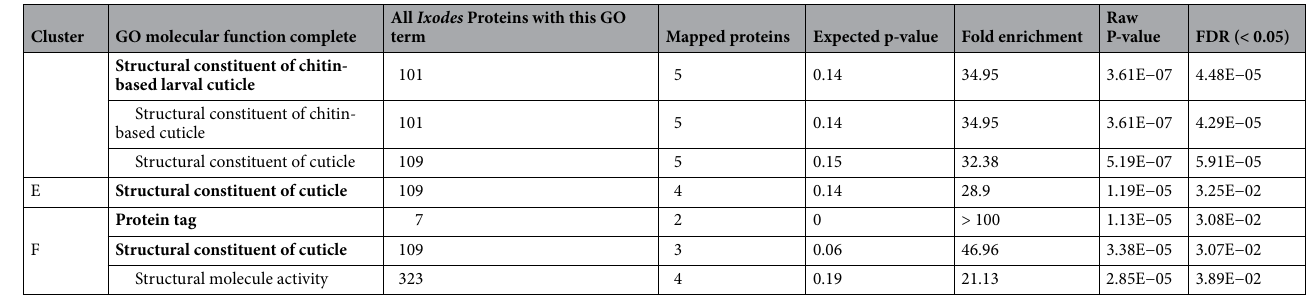
Table 1. Molecular function gene ontology (GO) terms enriched in tick